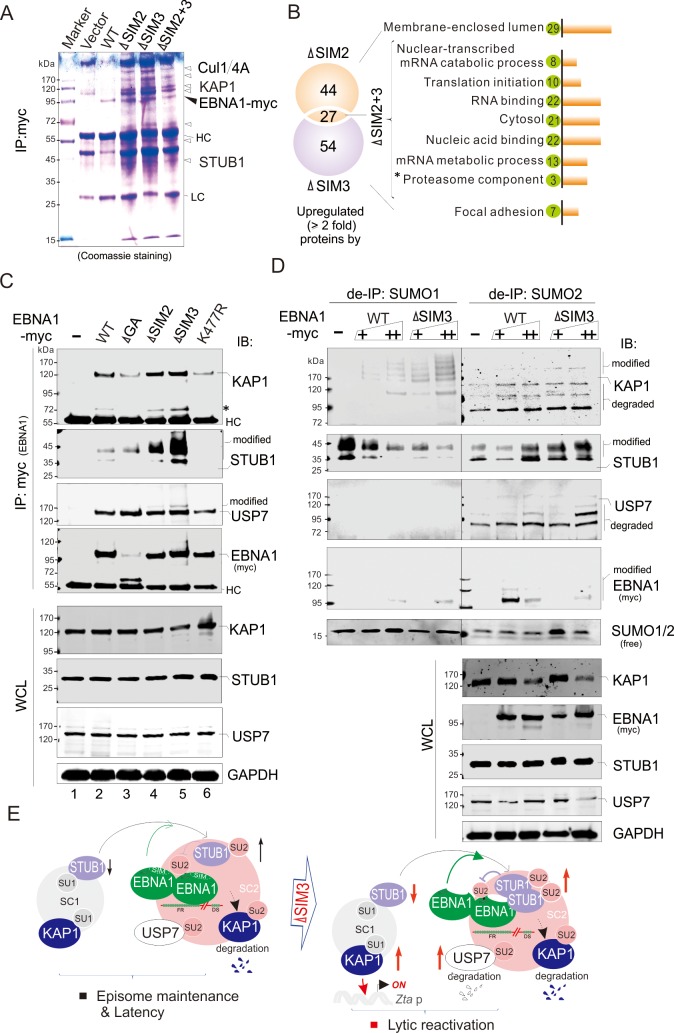
Deletion of EBNA1SIM significantly increases SUMO2-modified STUB1 and its association with EBNA1.(A) Identification of cellular proteins that specifically associate with EBNA1SIM. Whole cell lysates from HEK293 cells individually transfected with vector alone or vectors encoding WT EBNA1 with myc tag, or its SIM-deleted mutants (ΔSIM2, ΔSIM3, and ΔSIM2+3), were subjected to IP with anti-myc antibodies. Equal amounts of EBNA1-precipitated proteins were subjected to SDS-PAGE separation followed by Coomassie staining or directly MALDI-TOF-MS analysis. The heatmap and identified target protein are shown in S4 Fig and S4 Table, respectively. HC, heavy chain; LC, light chain. The EBNA1 and its SIM-associated target proteins (STUB1, KAP1, Cul1, and Cul4A) with more counts of peptide hits detected by MS are highlighted in the right panel. (B) The functional cluster of EBNA1-associated molecules upon deletion of EBNA1SIM. The number of cellular proteins related to functional clusters of DNA/RNA binding, mRNA metabolism, transcription and translation process with significant change (≥ 2 fold) in the absence of EBNA1SIM from panel A is shown in the green circles. The molecules related to the proteasome component are highlighted using asterisks. (C) Deletion of EBNA1SIM significantly increases the association of STUB1 with EBNA1. HEK293 cells were transfected with plasmids expressing WT EBNA1 or its mutants (ΔSIM2, ΔSIM3, ΔSIM2+3, and K477R) with myc tag. At 48 h post-transfection, WCL were subjected to IB or IP with anti-myc antibody followed by immunoblotting as indicated. The asterisk denotes an uncharacterized protein band of KAP1. The modified protein bands of STUB1 and USP7 were highlighted. HC, heavy chain. (D) Deletion of EBNA1SIM3 enhances EBNA1-mediated STUB1 modification switch from SUMO1 to SUMO2, SUMO1-modified KAP1 and SUMO2-mediated degradation of USP7. HEK293 cells were individually transfected with different amounts of vectors expressing WT EBNA1, its ΔSIM3 mutant or vector alone. At 48 h post-transfection, WCL were subjected to directly immunoblotting or de-IP with antibodies specific against SUMO1 or SUMO2, followed by IB as the indicated antibodies. The degraded KAP1 or USP7 with SUMO2 modification is highlighted in the figure. (E) Schematic presents the role of EBNASIM in the regulation of SUMO1 and SUMO2 -associated complex. The SUMO1- and SUMO2-associated complex (SC1 and SC2) is shown in gray and pink, respectively. The effect of EBNASIM deletion is highlighted by red arrows in the right panels.